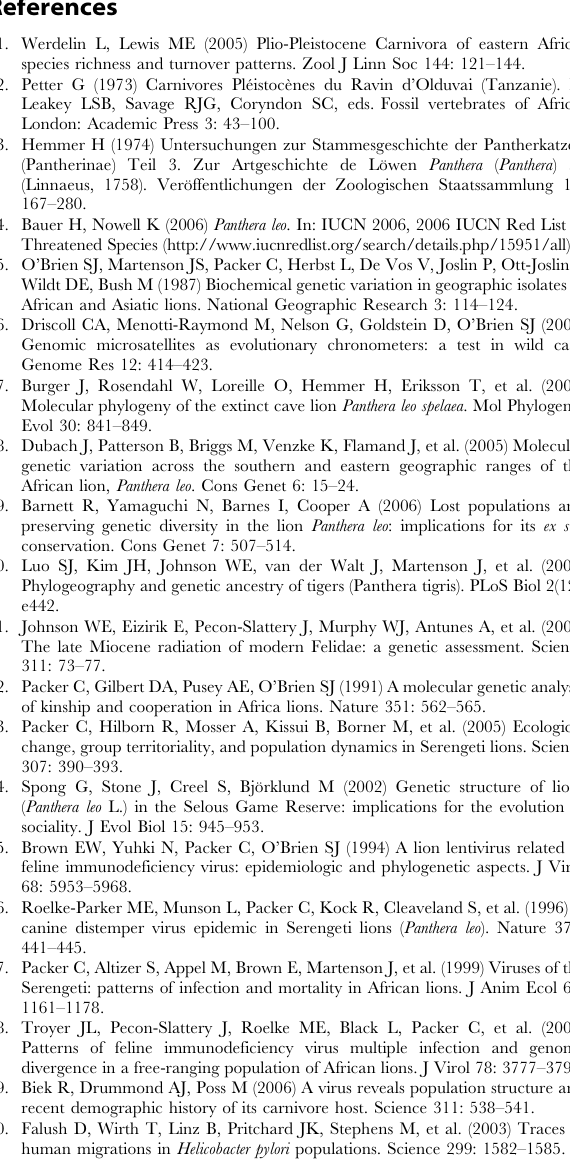
Table S4 Gene diversity and frequency values in lion popula- tions. Table S5 Bottleneck analysis in lion populations using the standardized differences test and the stepwise mutation model (SMM). Table S6 Results of the hierarchical AMOVA in lions for four different geographical scenarios. Table S7 Lion population pairwise F ST estimates. Below the diagonal mtDNA data ( 12S–16S ) and above the diagonal microsatellite data (22 loci). Table S8 Taxon specific unique nDNA alleles in lion popula- tions (FCA-microsatellites and ADA locus).